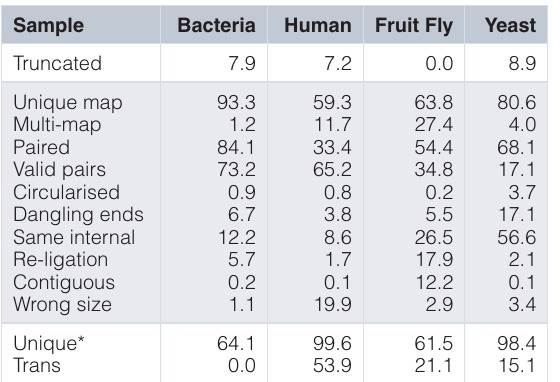
Table 3. Summary results of processing previously published datasets with HiCUP. Each value is represented as a percentage of the reads or read-pairs processed at the given stage of the pipeline. (*Unique corresponds to the percentage of di-tags retained after removing all but one representative copy of each